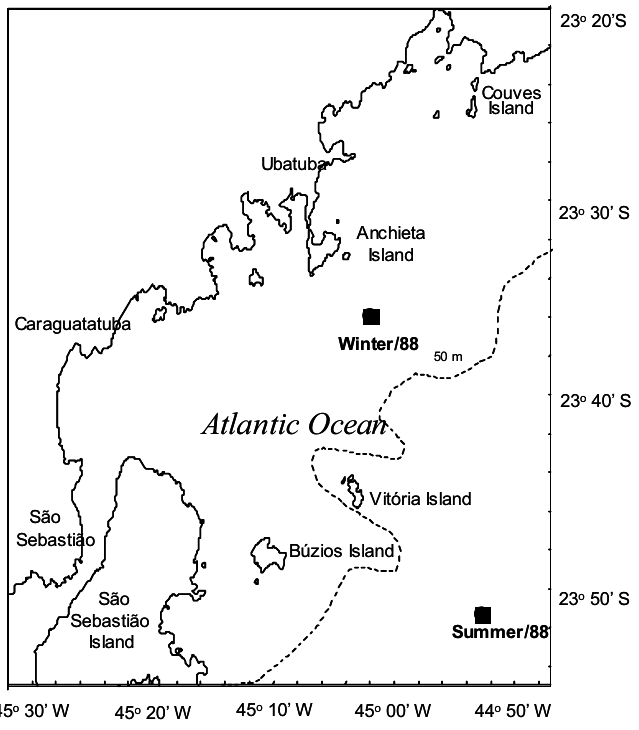
Fig. 1. Sampling area on the southeastern Brazilian shelf and the trawl stations location.